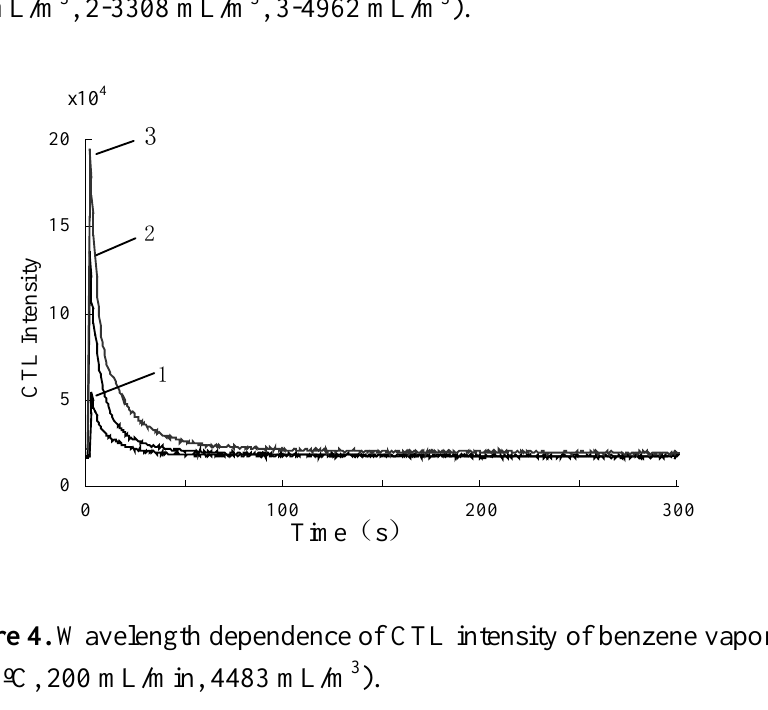
Figure 3. CTL response profiles of different concentrations of benzene vapor (1-1654 mL/m 3 , 2-3308 mL/m 3 , 3-4962 mL/m 3 ).